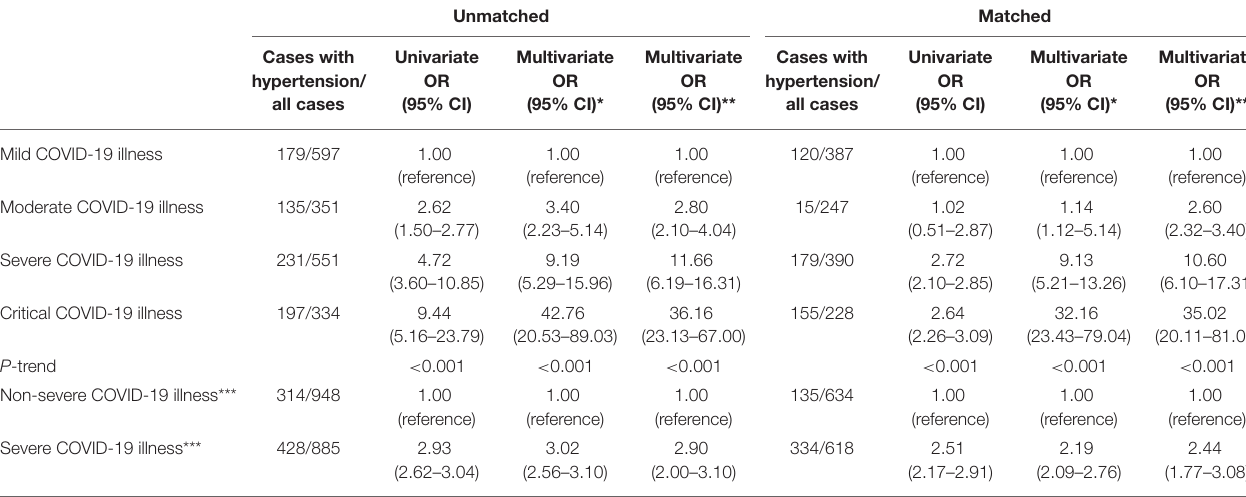
TABLE 2 | The association between hypertension and the COVID-19 severity in the deceased COVID-19 patients using the logistic regression analysis before and after the propensity score-matching a . Unmatched